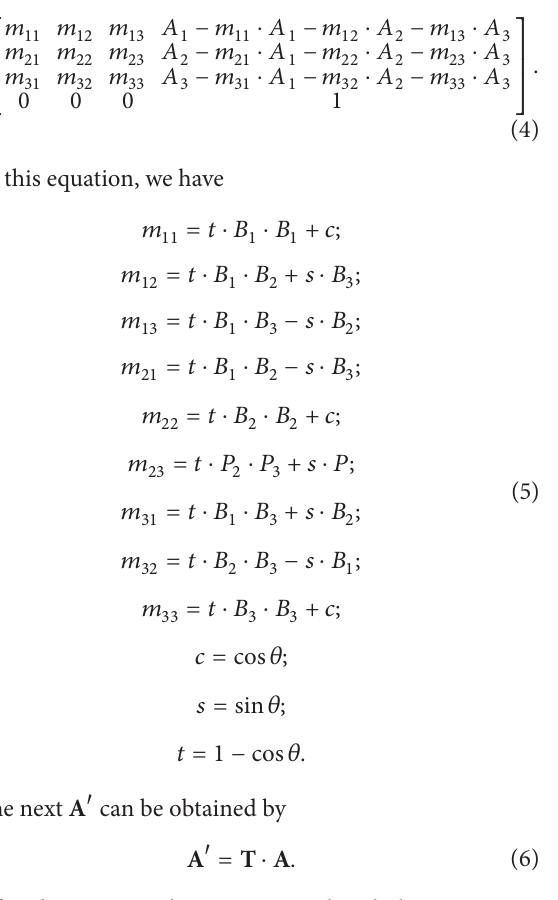
Figure 2: Result of dynamic safe pipe